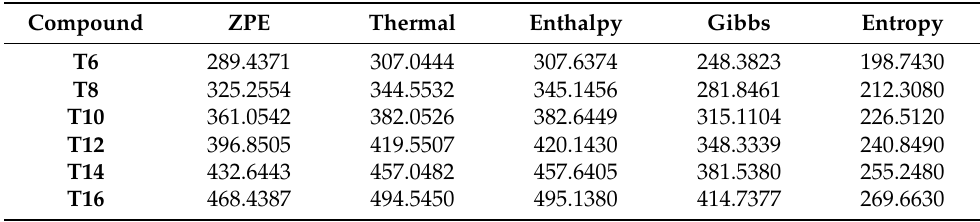
Table 4. Zero-point energy, thermal energy and thermodynamic parameters in kcalmol − 1 for the compound Tn series calculated at the B3LYP/6–31g(d,p) level. Compound ZPE Thermal Enthalpy Gibbs